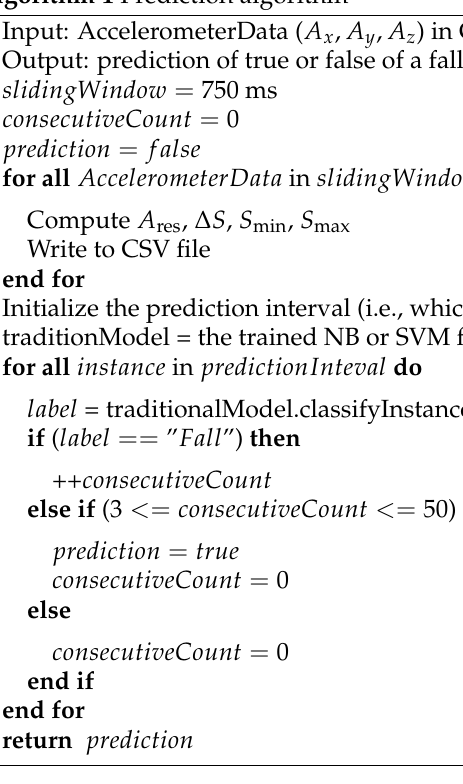
Algorithm 1 Prediction